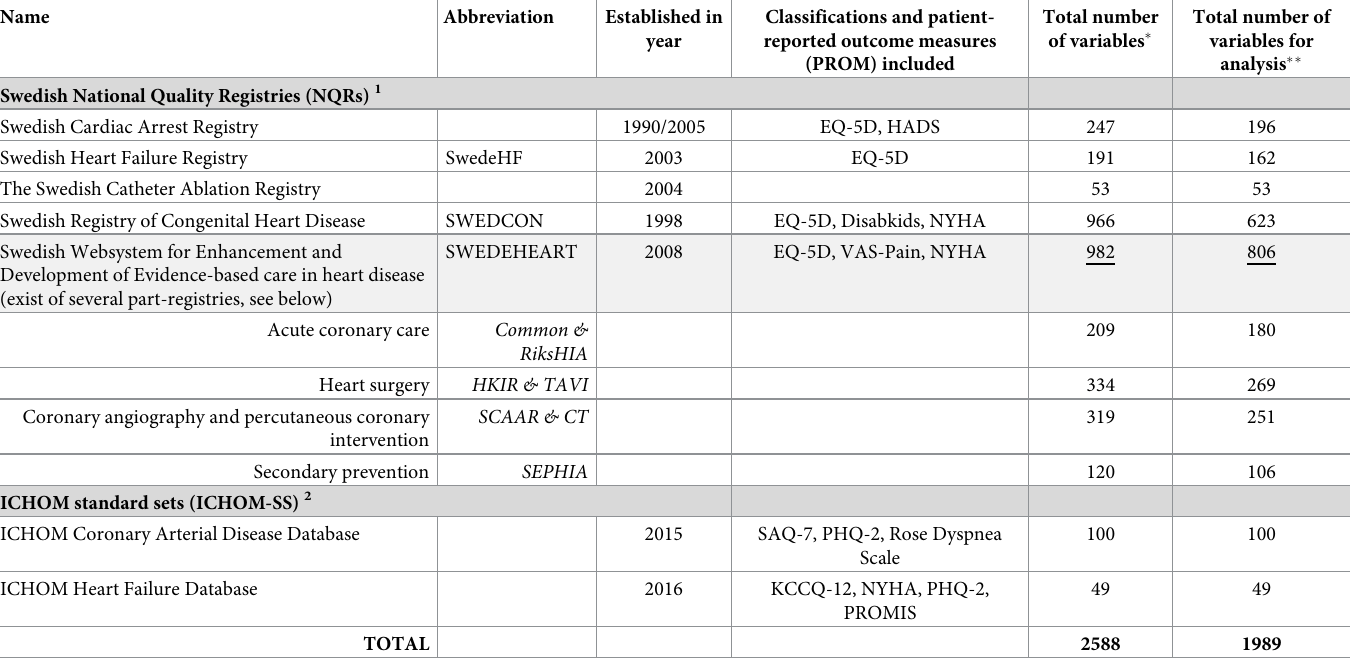
Table 1. National quality registries and ICHOM standard sets included in the content analysis.